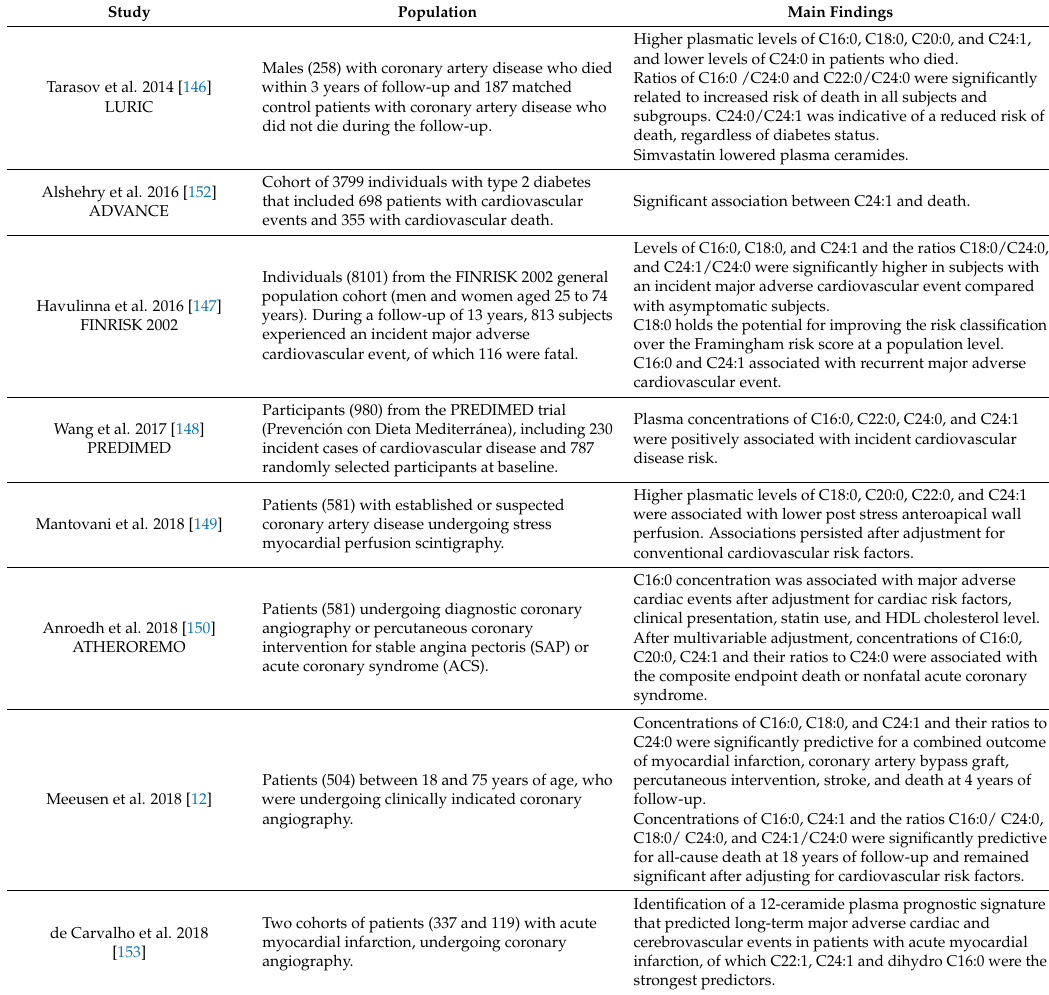
Table 2. Plasma levels of ceramide and cardiovascular disease. Study Population Main